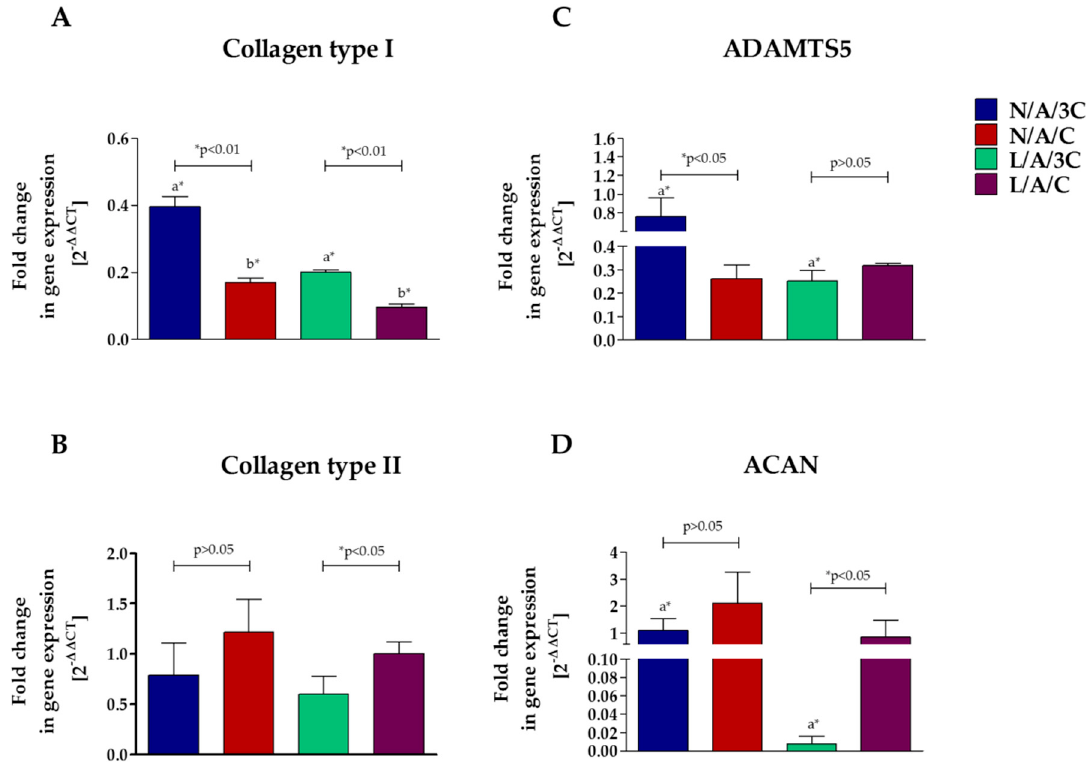
Figure 14. The results of gene expression analysis of Coll-1 ( A ); Coll-2 ( B ); ADAMTS5 ( C ) and ACAN ( D ) in hASCs cultured on biomaterials. The 2 −ΔΔ C t method was used to calculate the quantification of relative values, normalizing data to control and including expression of reference gene ( GAPDH ). Error bars represent standard deviation from the mean calculated for normalized values obtained in three separate replicates. An asterisk (*) represents statistically significant differences ( p ˂ 0.05).